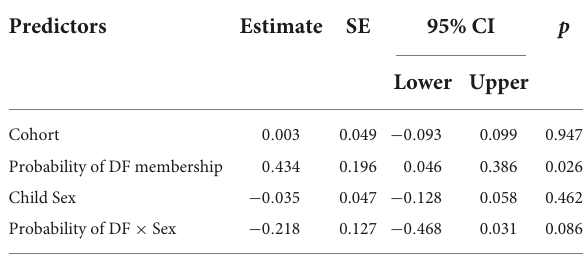
TABLE 6 Summary of multiple regression of membership in dysregulated fear (DF) profile, child sex, and their interactions on maternal report of social withdrawal on the Health and Behavior Questionnaire (HBQ) at child age 6.